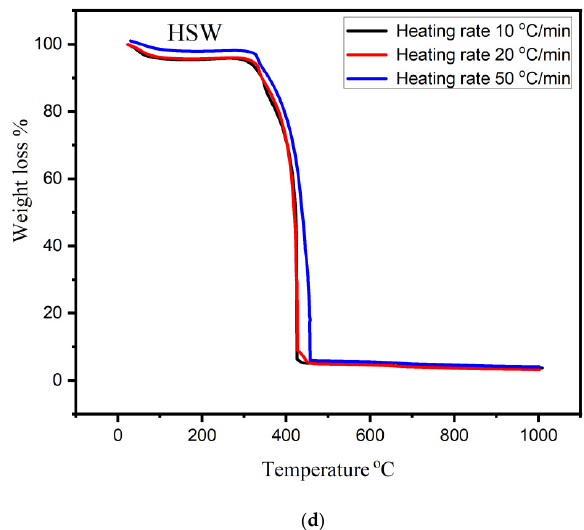
Figure 4. ( a – b ) TGA profiles of ( a ) PSW, ( b ) TSW, ( c ) MSW and ( d ) HSW biochar in an oxidizing atmosphere at 10, 2, and 50 °C/min heating